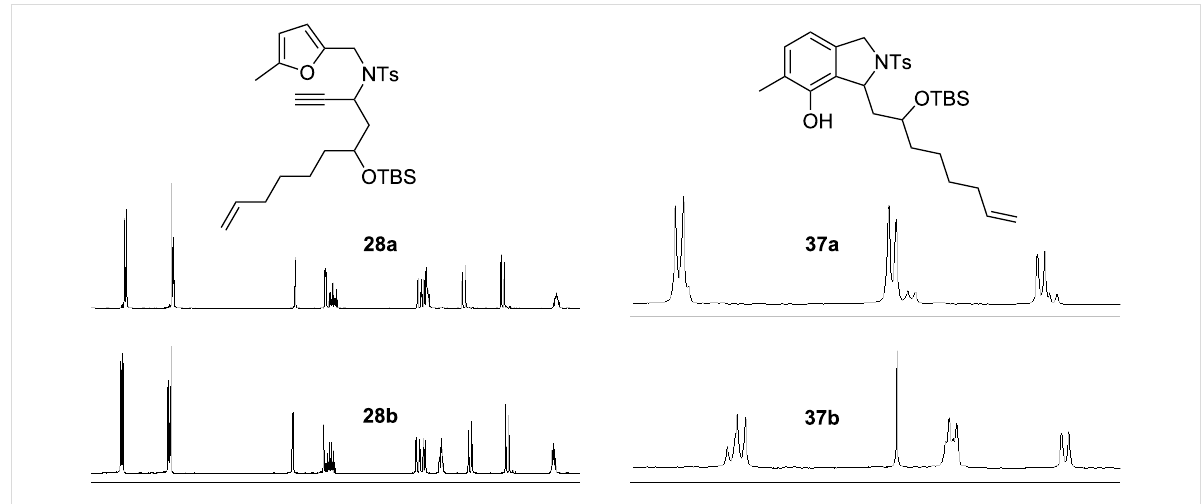
Figure 4: 1 H NMR spectra of the separated diastereoisomers of the substrates for catalysis 28 (left) and of the products 37 (right, the small signals are due to the deprotected compounds 38 ).